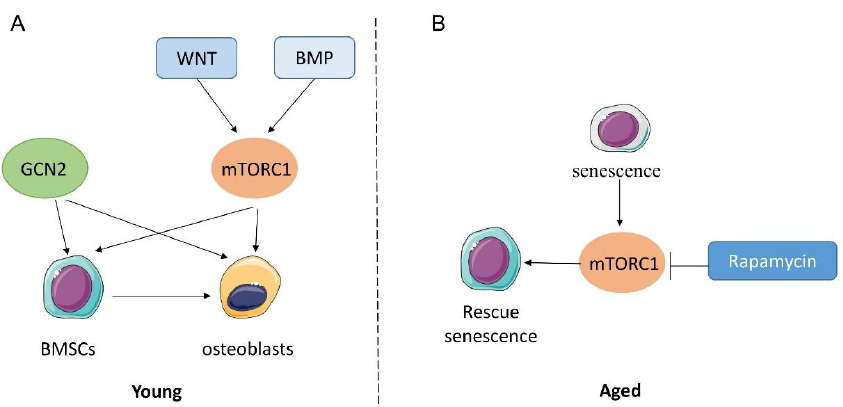
Figure 2. GCN2 and mTORC1 signaling in BMSC-osteoblast lineage cells in vitro at young ( A ) and aged ( B ) stage.